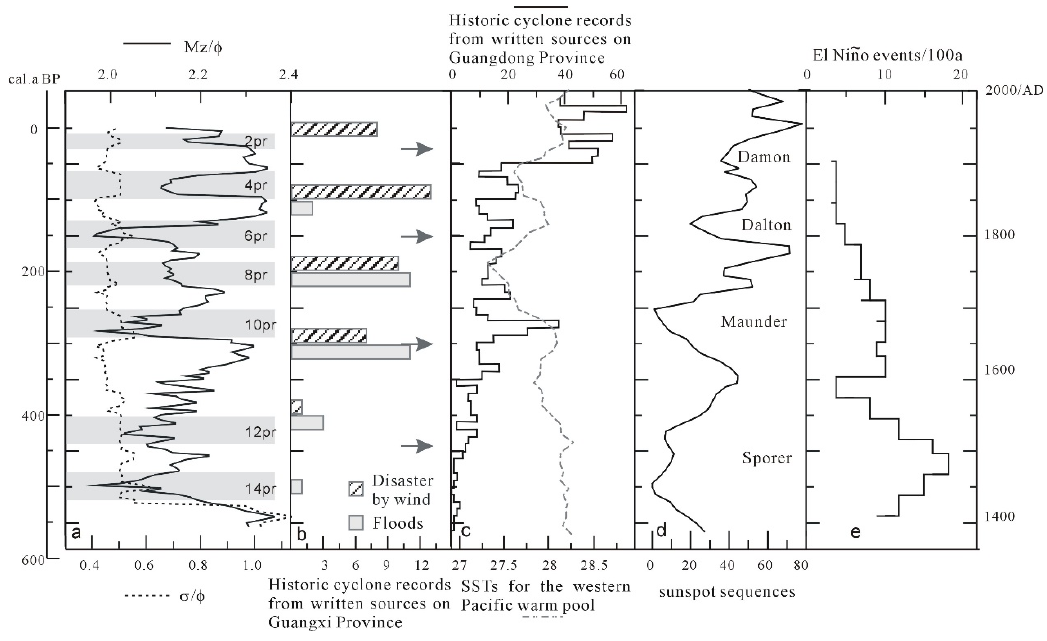
Figure 5. A comparison of the large tropical cyclone event periods in Beibu Gulf, Guangxi Province, China with paleo- cyclone records for the South China Sea over the LIA. ( a ) Large tropical cyclone event periods at the Wutou section (WTS) Scheme 55. ( b ) Historic cyclone records for Guangxi Province from written sources [51]. ( c ) Historic cyclone records for Guangdong Province from written sources [13]. Sea surface temperatures (SSTs) for the western Pacific warm pool (WPWP) from core MD98-2181 [57]. ( d ) Inferred changes in Holocene El Niño frequency from Laguna Pallcacocha, Ecuador [58]. ( e ) Sunspot sequences [59].